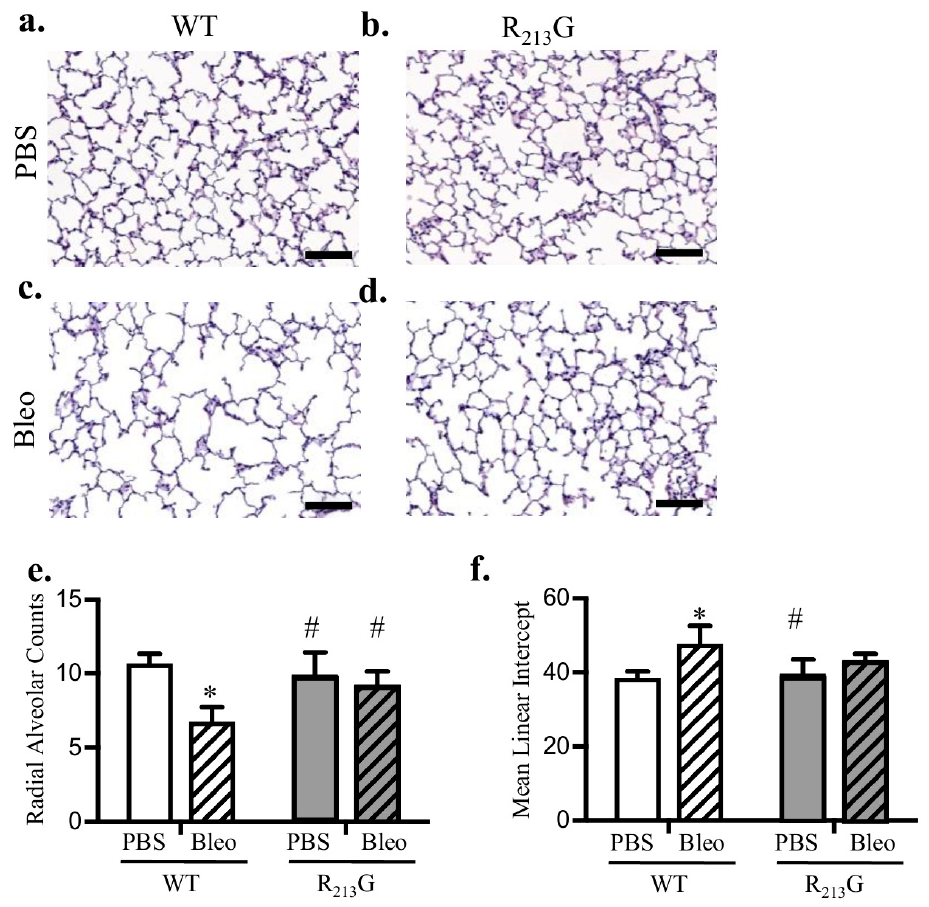
Figure 6. The SOD3 R 213 G SNP mitigated bleomycin induced alveolar simplification at 22 days. ( a – d ) Representative images of H&E staining in ( a ) WT PBS, ( b ) R 213 G PBS, ( c ) WT Bleo, ( d ) R 213 G Bleo, scale bar = 100 µ m. ( e ) Radial alveolar counts in WT and R 213 G mice following IP PBS or bleomycin exposure, * p < 0.05 vs. WT PBS by two-way ANOVA, n = 5–8. ( f ) Mean linear intercept in WT and R 213 G mice following IP PBS or bleomycin exposure, scale bar = 200 µ m * p < 0.05 vs. WT PBS by two-way ANOVA; # p < 0.05 vs. WT Bleo by two-way ANOVA n = 7–8.